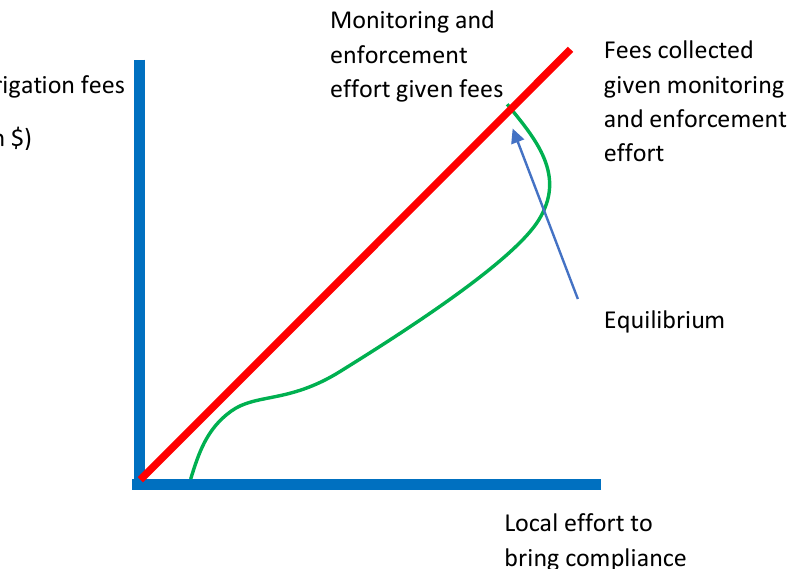
Figure 5. Hypothesised relationships between monitoring and enforcement given fees paid and fees paid given monitoring and enforcement, assuming a high local retention of fees.